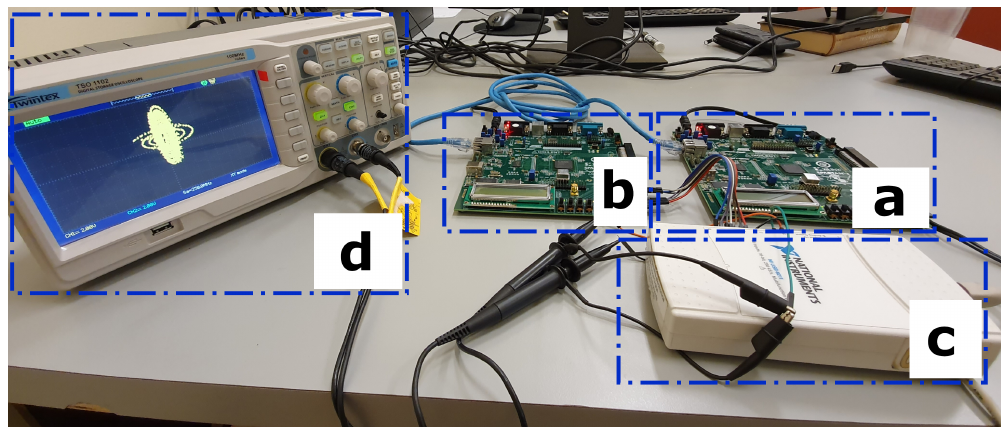
Figure 2. Synchronization scheme using two SPARTAN–3AN starter kit boards: ( a ) Master system. ( b ) Slave system. ( c ) DAC. ( d ) Data acquisition.